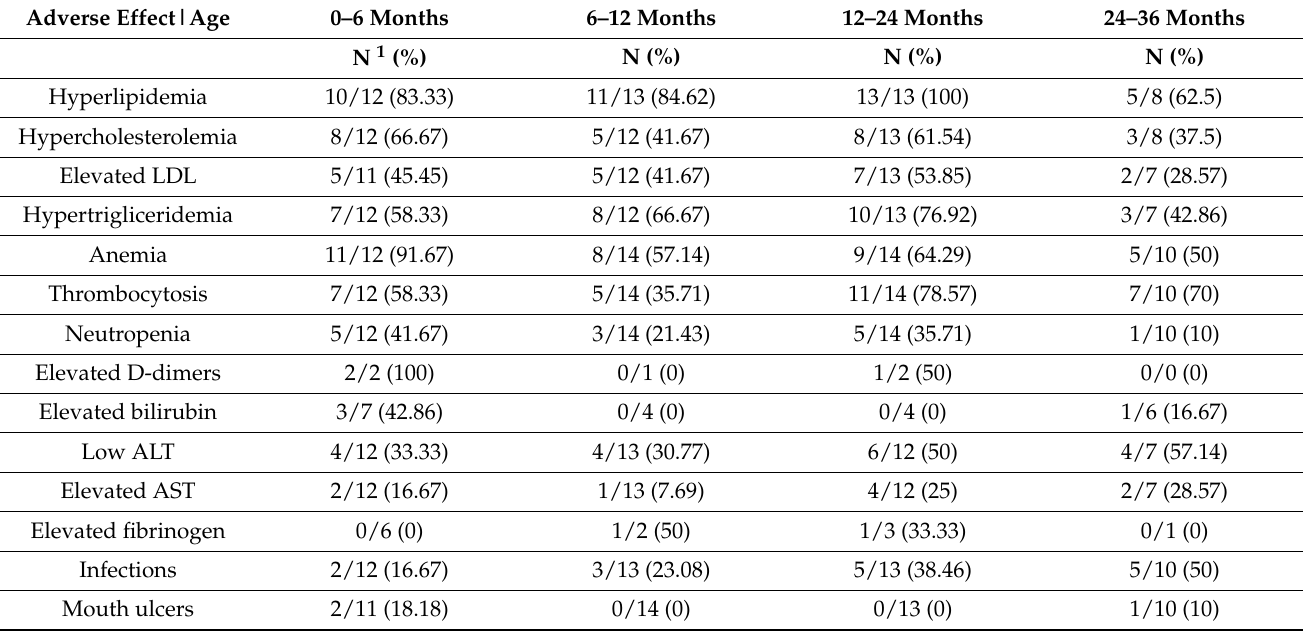
Table 2. Sirolimus adverse effects depending on